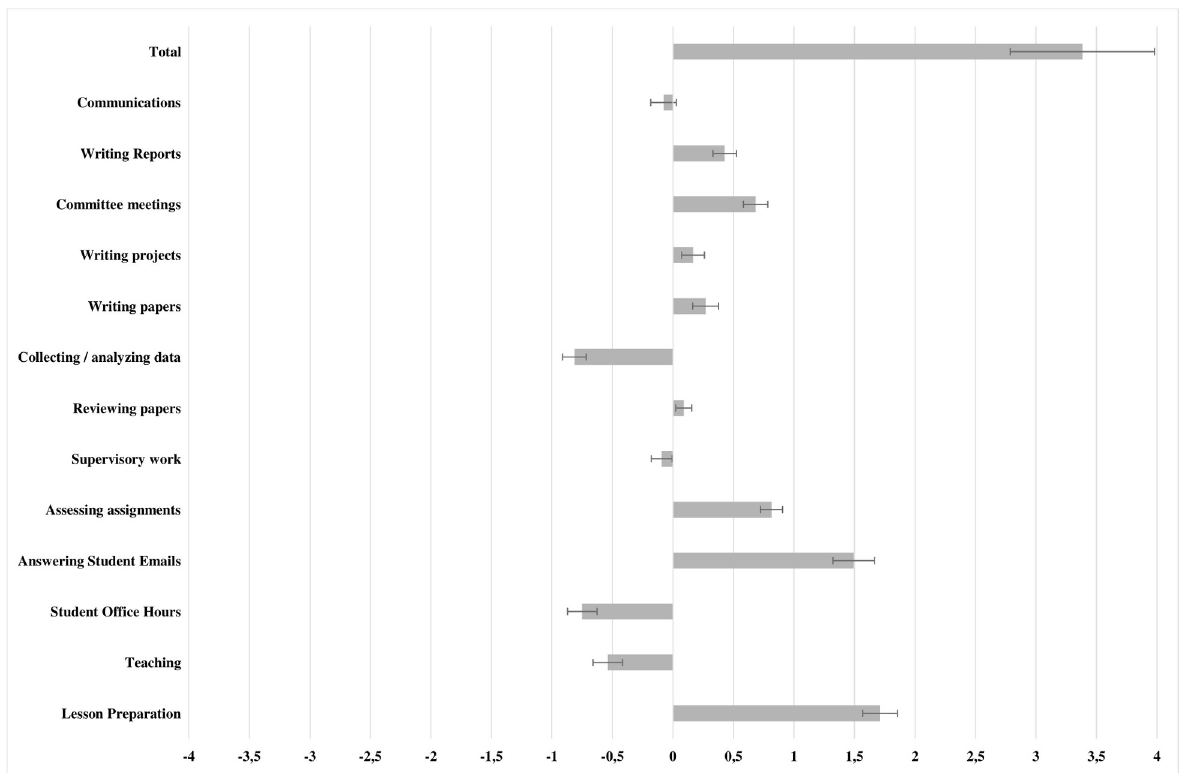
Fig 2. Differences between observed and expected changes in working hours per week in the first pandemic semester, relative to the previous semester. Error bars indicate 95% confidence intervals.